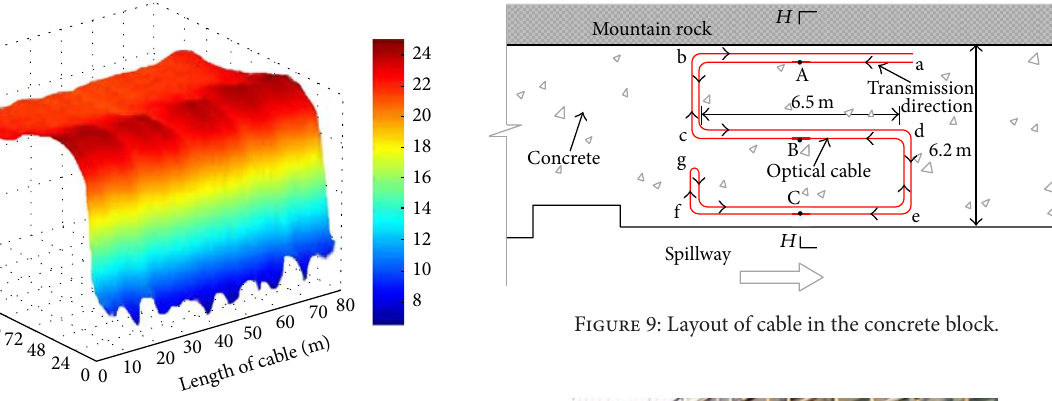
Figure 7: DTS measured temperature cloud.